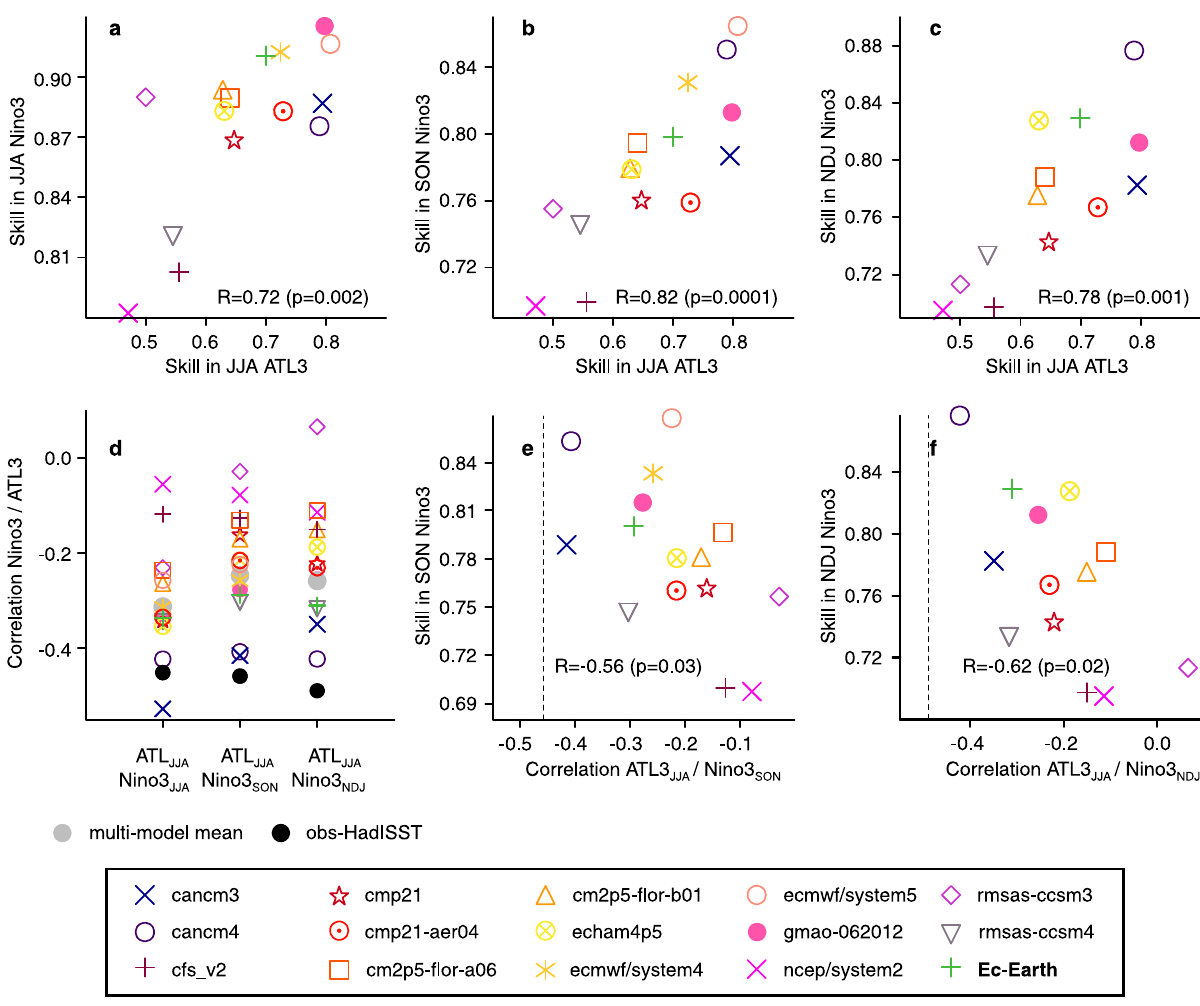
Fig. 2 Atlantic/Paci fi c relationships in the multi-model ensemble. a – c Scatter plots of prediction skill (in terms of ACC) in JJA ATL3 against the ACC prediction skill of Niño3 SST in JJA, SON, and NDJ, respectively. d Strength of the teleconnection in the predictions systems, evaluated by the correlation coef fi cient of ATL3 SST in JJA and Niño3 SST at different forecast ranges (JJA, SON, and NDJ). The corresponding observed values for HadISST v1.1 are shown with black dots. e , f Scatter plots of the prediction skill in SON/NDJ Niño3 SST against the strength of the teleconnection between JJA ATL3 SST and SON/NDJ Niño3 SST, respectively. Vertical lines in panels e and f indicate the strength of the correlations in observations. The period is 1981 – 2011. In all scatter plots the Pearson ’ s correlations and corresponding p values are